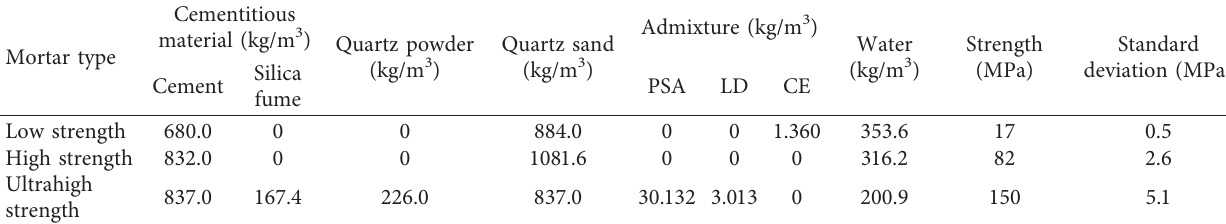
Table 1: Mix proportions and cube compressive strength.